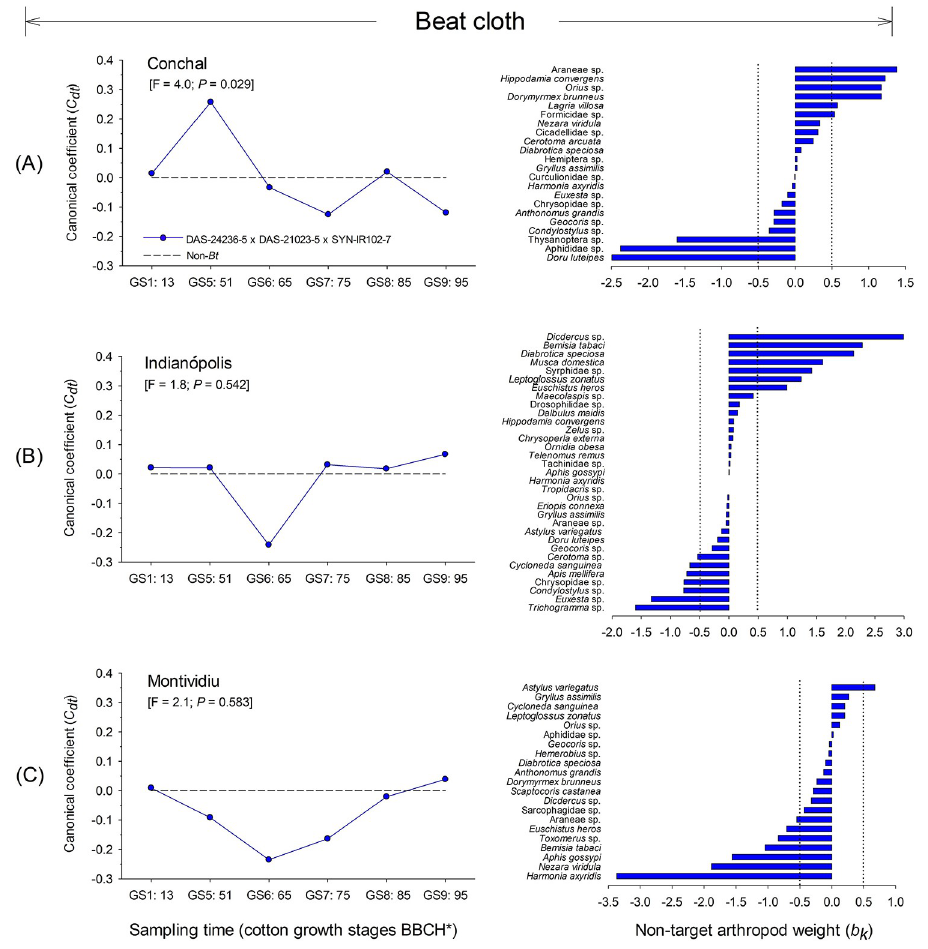
Fig 4. Principal response curves (PRCs) and taxon weights of foliar-dwelling arthropod populations collected via beat cloth sampling from DAS-21023-5 × DAS-24236-5 × SYN-IR102-7 Bt cotton compared with a non- Bt cotton variety at three sites in Brazil (2014/2015 cropping season). Dotted line indicates the response within the non- Bt cotton entry. If a significant P-value was detected ( < 0.05, Monte Carlo test), taxa with positive weights followed the PRC pattern, whereas those with negative weights showed the opposite pattern. Taxa with weights between approximately -0.5 and 0.5 did not contribute significantly to the overall pattern. If a P-value was non-significant, species patterns were random in relation to treatments. � Phenological growth stages of cotton classified according to Munger et al. (1998). (Hymenoptera) and Phoridae sp. (Diptera) were the NTAs that most contributed to the com- munity response, with the highest and lowest weights, respectively (Fig 6C). Where a significant Monte Carlo test indicated potential differences for NTAs sampled using sticky card traps at Indiano´polis, a two-way RM-ANOVA for taxa with weights ( bk ) > | 0.5| identified that Bethylidae species 01 (Hymenoptera) (F = 7.1; df = 5, 15; P = 0.001), Eucoi- linae species 02 (F = 4.0; df = 5, 15; P = 0.016), Ichneumonidae species 29 (Hymenoptera) (F = 8.6; df = 5, 15; P < 0.001), Frankliniella schultzei (Thysanoptera: Thripidae) (F = 3.2; df = 5, 15; P = 0.038), F . occidentalis (F = 3.2; df = 5, 15; P = 0.037) and Diptera morphotype 16 (F = 7.8; df = 5, 15; P < 0.001) showed significant interaction between cotton type and sam- pling time (S2 Table, Fig 7). The abundance of the hymenopteran parasitoids Bethylidae sp. 01 at the GS5:51 cotton growth stage and Ichneumonidae sp. 29 during the GS5:51 and GS6:65 cotton stages were lower in DAS-21023-5 × DAS-24236-5 × SYN-IR102-7 plots compared